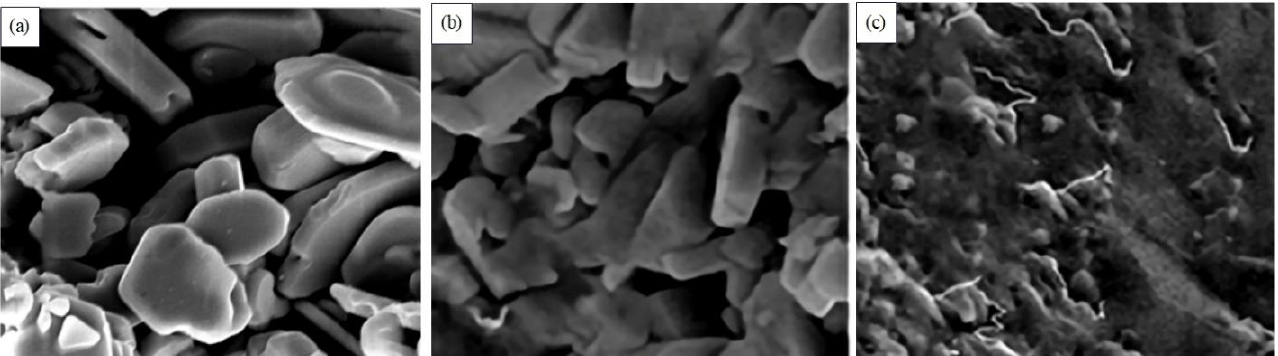
Figure 2. SEM images of the powders ( a ) TiB 2, ( b ) Si 3 N 4 , and ( c ) B 4 N.